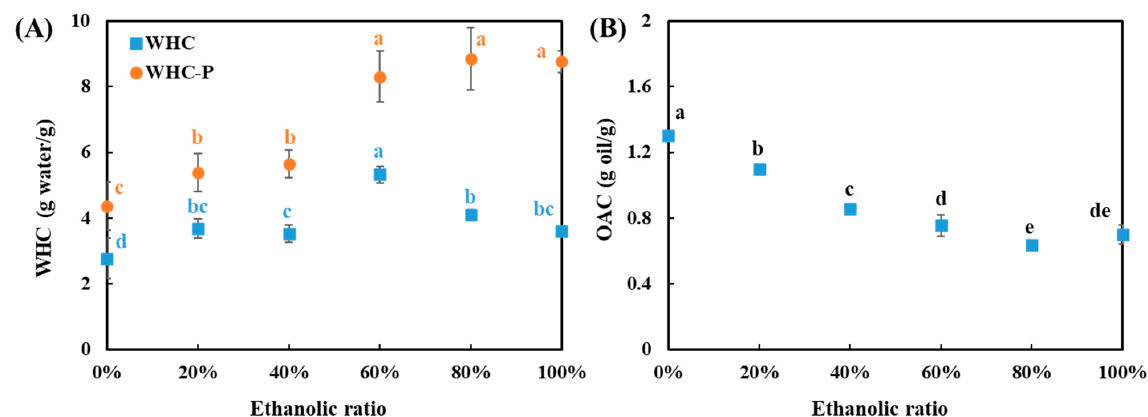
Figure 8. ( A ) Water holding capacities (WHC and WHC P ), and ( B ) oil absorption capacity (OAC) of all soy protein Figure 8. The WHC, WHC P ( A ), and OAC ( B ) of all the soy protein concentrates (SPCs). The values in the figure are com- concentrates (SPCs). The values in the figure are compared in series (same color) and different top letters (a,b,c,d,e) indicate pared in series (same color) and different top letters (a,b,c,d,e) indicate a significant difference ( p < 0.05). a significant difference ( p < 0.05).